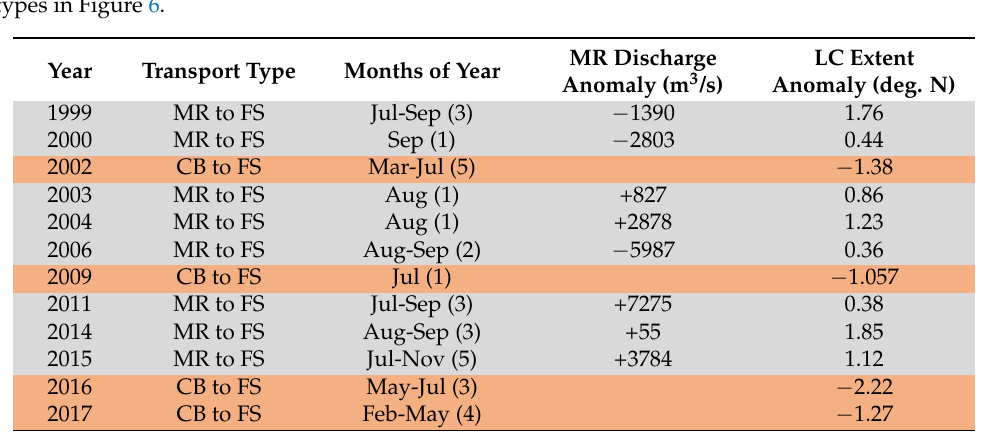
Table 1. Months of the year (with duration in parentheses), anomalies of Mississippi River (MR) discharge, Loop Current (LC) northward extent during episodes of Mississippi River Delta (MD) to Florida Straits (FS), and Campeche Bank (CB) to FS transport. Shading matches that of transport event types in Figure